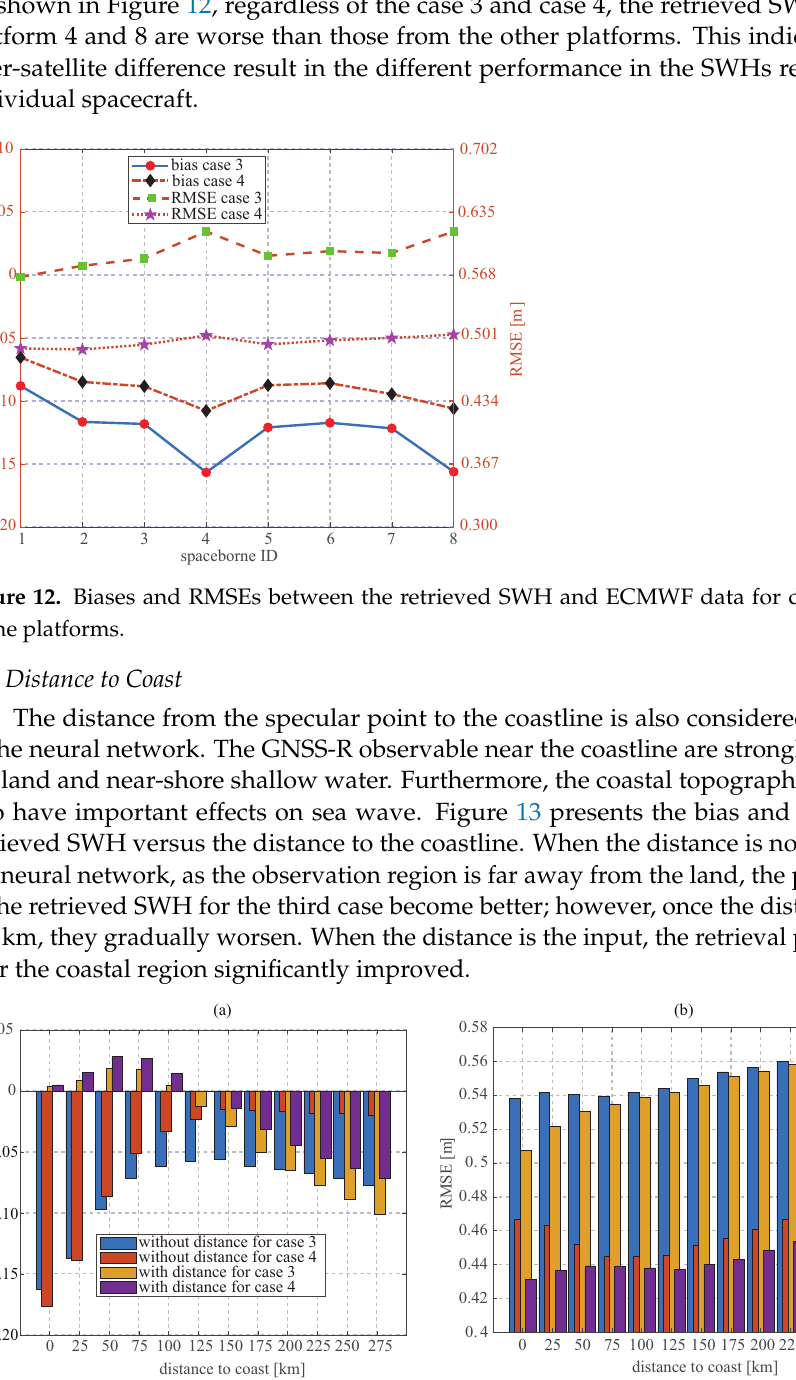
Figure 13. ( a ) Biases and ( b ) RMSEs between the retrieved SWH and ECMWF data at different distances from the specular point to the